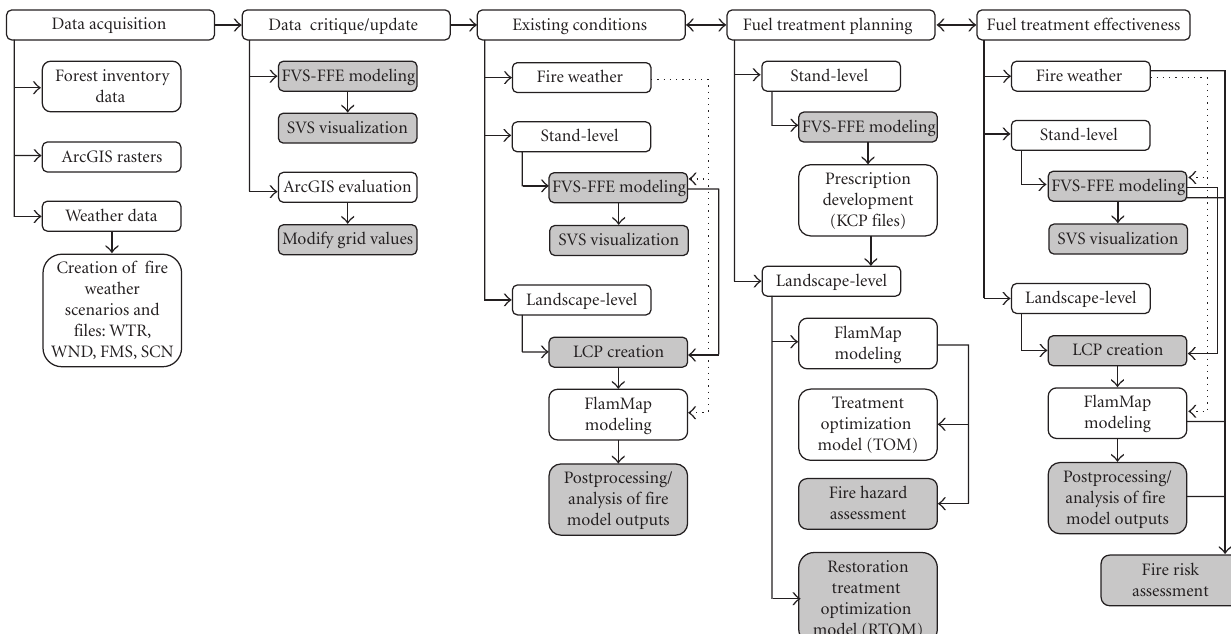
Figure 3: Flow chart of the analysis process to design and test fuel treatment and other vegetation management projects as required by the National Environmental Policy Act. Several treatment alternatives must be proposed and analyzed that address the project purpose and need (e.g., reducing fire risk) and impacts on other resource values. Automation of the analysis process with ArcFuels makes it possible to explore more treatment alternatives and leverage fire behavior models in the process.